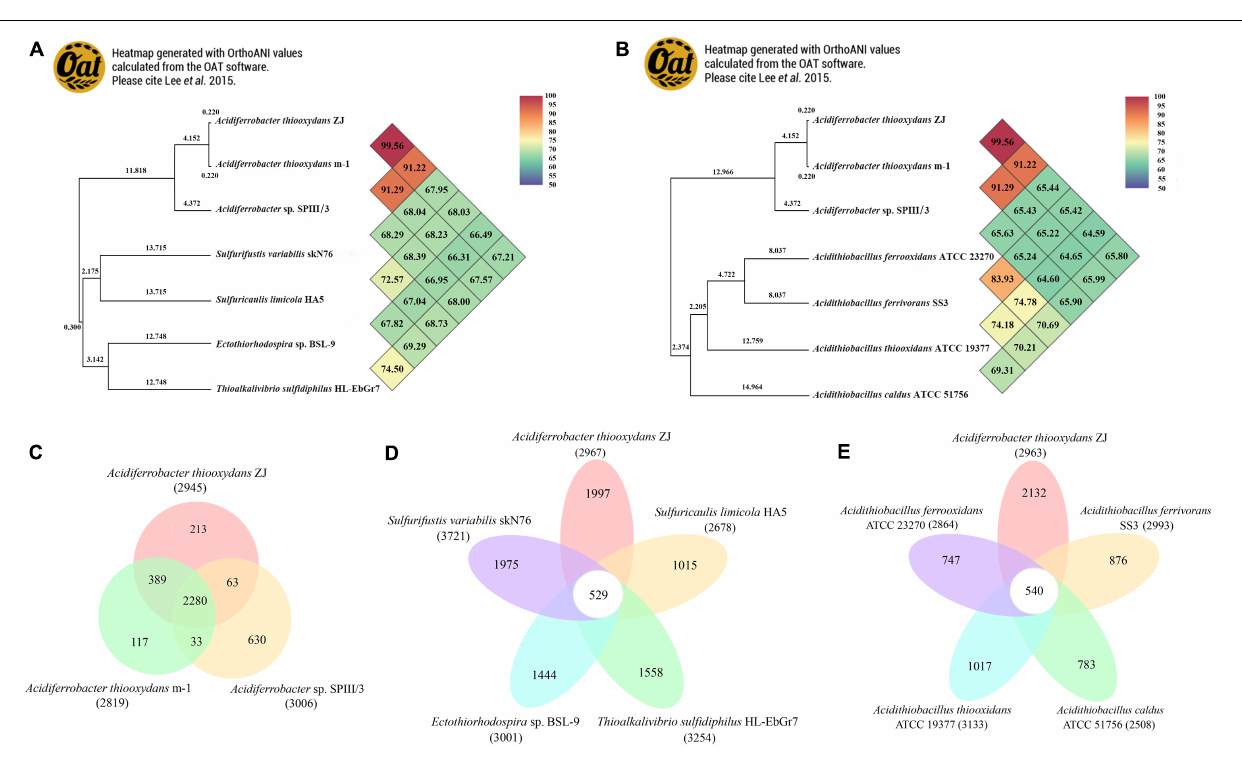
Figure 4 , the strain Af. thiooxydans ZJ and Af.